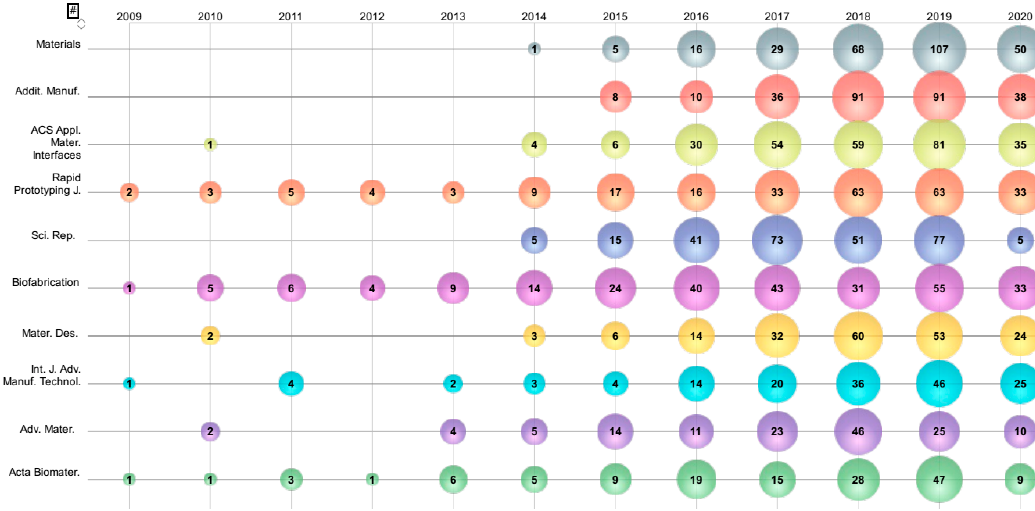
Figure 7. Bubble chart of the top 10 most productive journals by year.